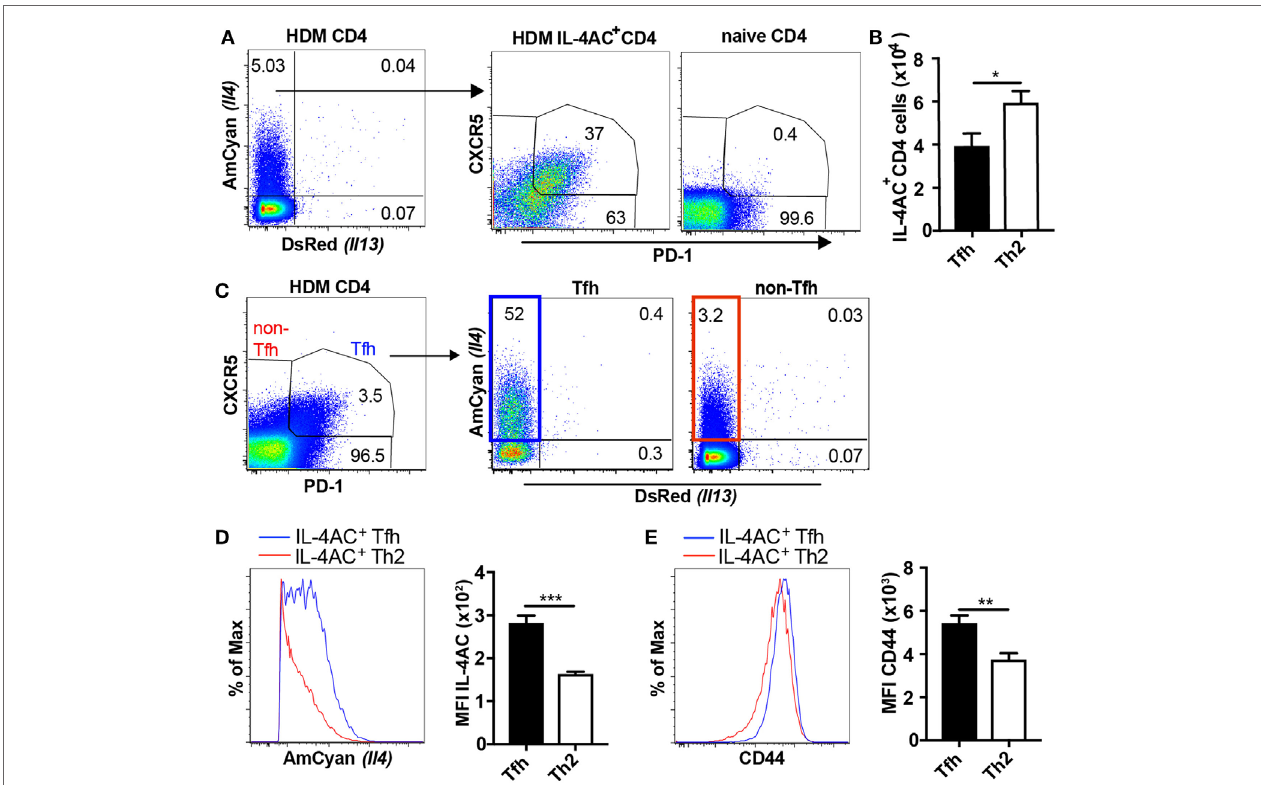
FigUre 2 | Both T follicular helper (Tfh) cells and Th2 cells contribute to IL-4AC expression in the lymph node after house dust mite (HDM) challenge. 4C13R transgenic mice were treated with 200 μ g HDM i.d. in the ear. The ear draining lymph nodes were harvested 7 days posttreatment and analyzed by flow cytometry. (a) FACS plots showing the proportion of IL-4AC + CD4 T cells and then the proportion of CXCR5 + PD-1 + Tfh and CXCR5 lo PD-1 lo , CXCR5 + PD-1 lo , and CXCR5 lo PD-1 + Th2 cells within this population. (B) Numbers of IL-4AC + Tfh and IL-4AC + Th2 CD4 T cells. (c) FACS plots showing the proportion of CXCR5 + PD-1 + Tfh and CXCR5 lo PD-1 lo , CXCR5 + PD-1 lo , and CXCR5 lo PD-1 + non-Tfh CD4 T cells and then the proportion of IL-4AC + CD4 T cells within these populations. Median fluorescent intensity (MFI) of IL-4AC (D) and CD44 (e) expression on IL-4AC + Tfh and IL-4AC + Th2 CD4 T cells. (a,c–e) Data from a representative experiment ( n = 6) of four experiments. (B) Data pooled from four experiments ( n = 23). Data show mean + SEM (* p ≤ 0.05, ** p ≤ 0.01, and *** p ≤ 0.001 two-tailed t